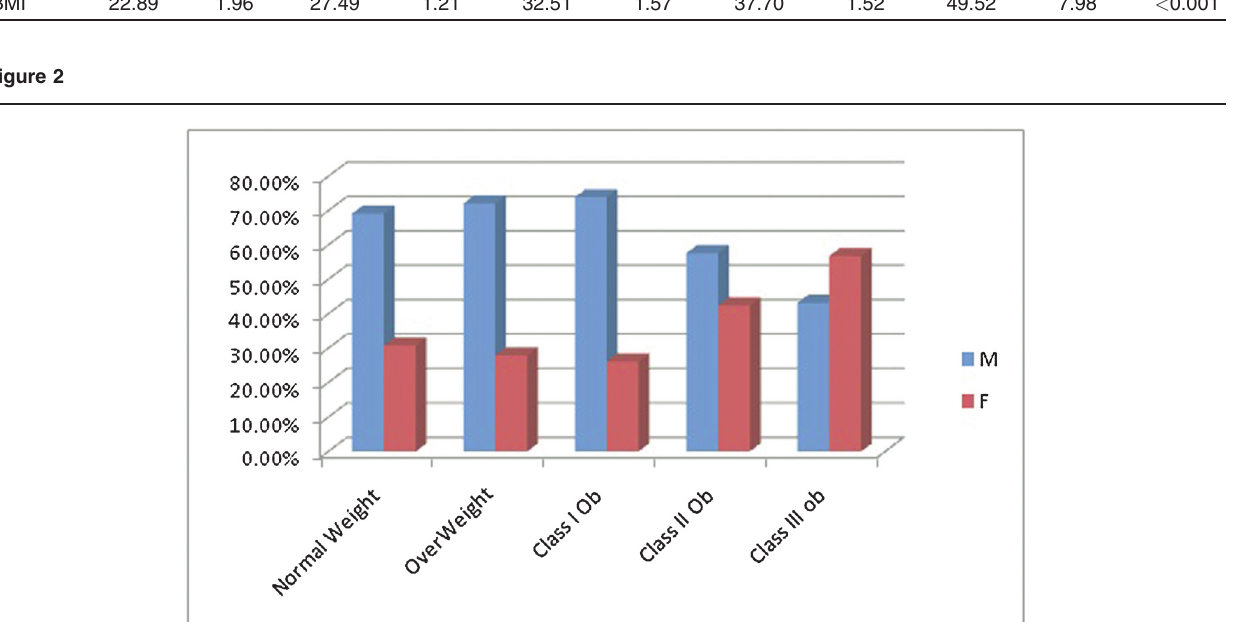
Sex distribution among study groups. F, female; M, male.